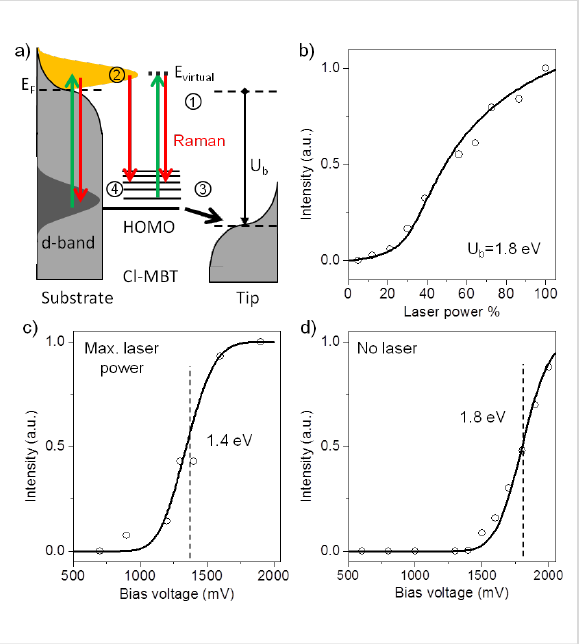
Figure 4: (a) Schematic energy level diagram of the gap/molecule hybrid system in a laser-illuminated tunneling junction. The normalized experimental data (open circles) and the calculated total emission (solid lines) as a function of the incident flux for fixed U b (1.8 eV) (b), as a function of the bias voltage U b for fixed incident flux (c) and for no laser illumination